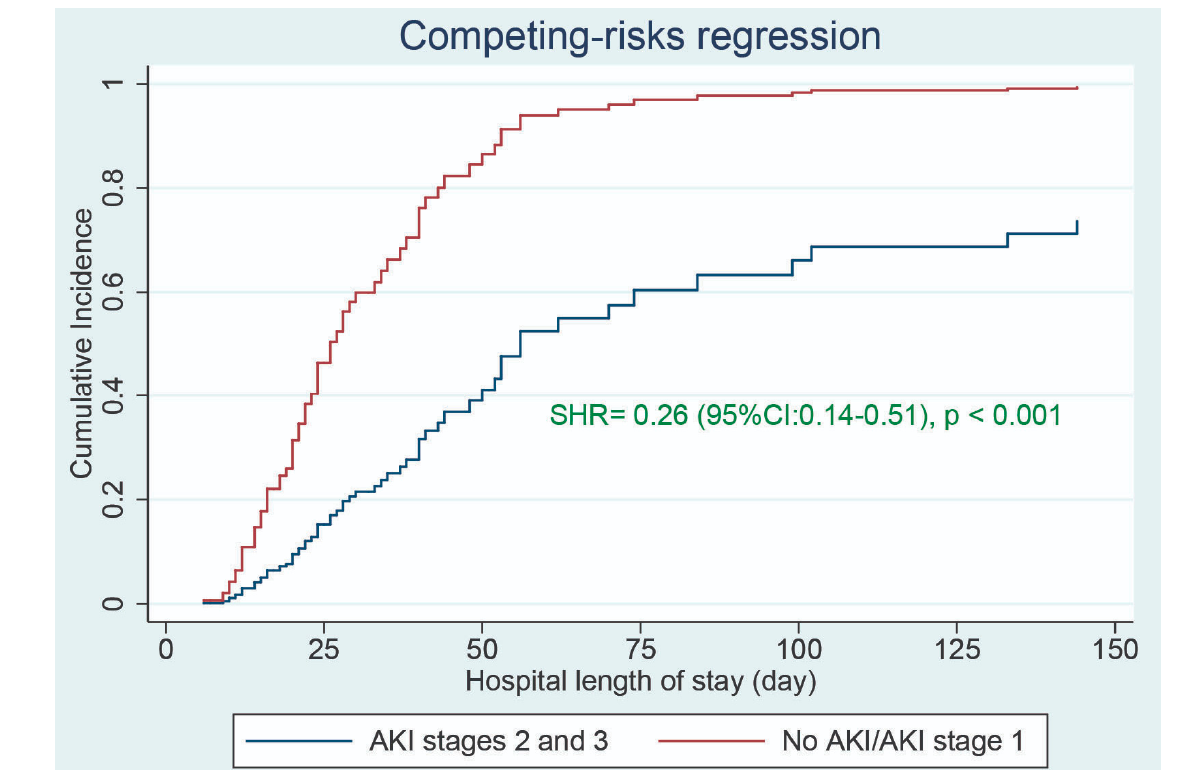
Figure 2. Comparisons of cumulative incidence function of hospital discharge between patients who had severe AKI (KDIGO stages 2 and 3) and those who did not. SHR: subhazard ratio. Among the 50 patients with severe AKI, 27 (54%) were discharged alive from the hospital. At hospital discharge, 20 of 27 (74.1%) recovered normal or baseline renal